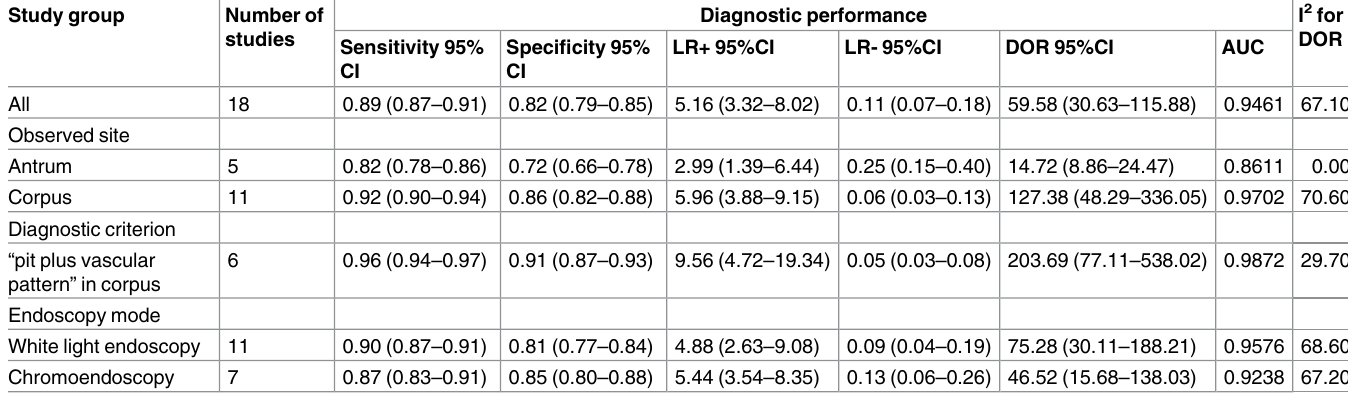
Table 3. Diagnostic performance of magnifying endoscopy for H . pylori